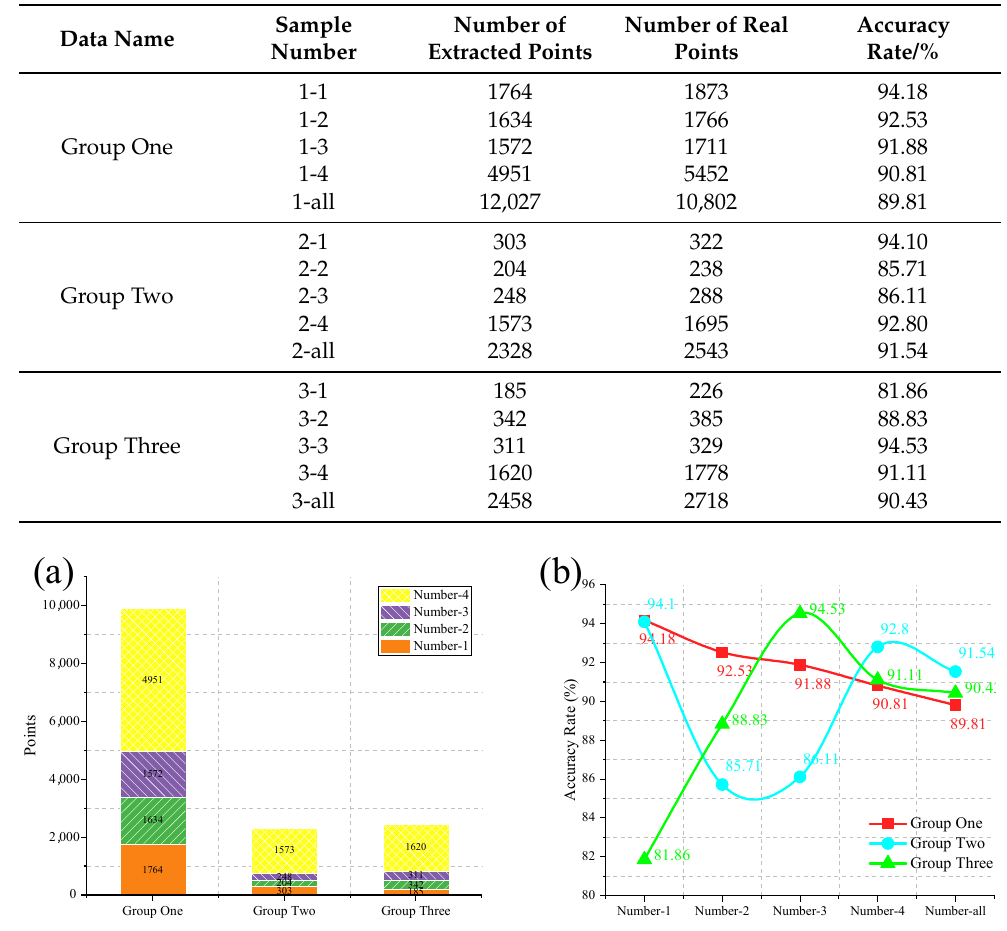
Table 3. Statistical table showing the accuracy rate of ropeway point cloud segmentation and extraction.